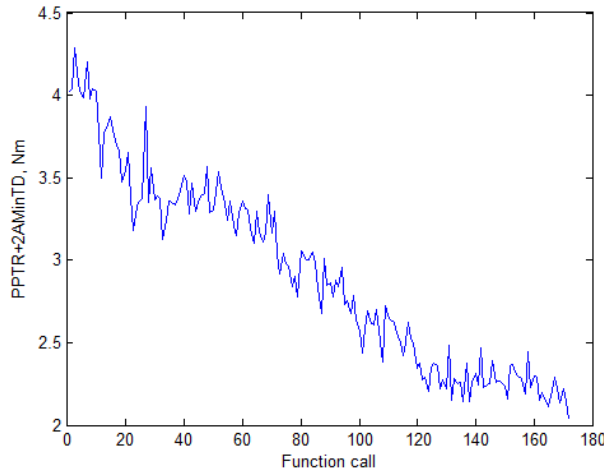
Figure 8. Change of the motor efficiency during the optimization.